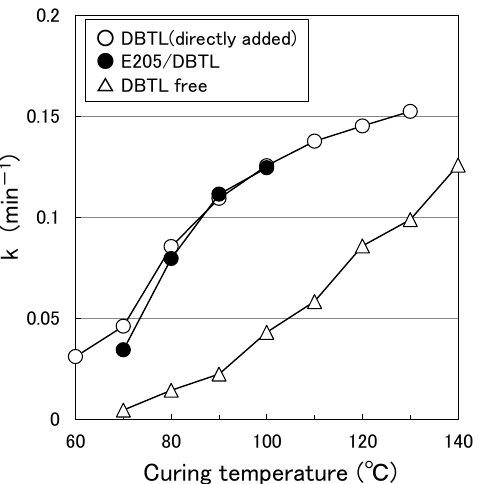
Figure 2. Relationship between the curing speed constant (k) and curing temperature (surfactant: E-205).